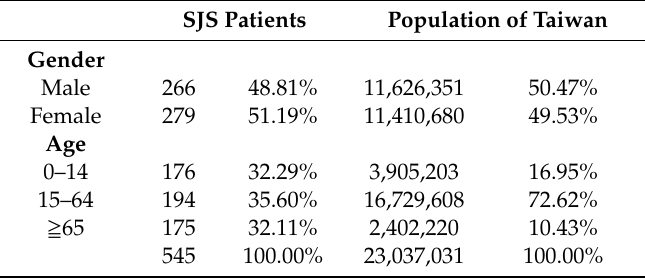
Table 1. Characteristics of the study and population of Taiwan.